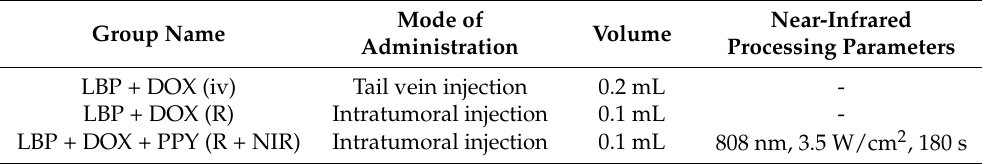
Table 1. Experimental grouping of tissue